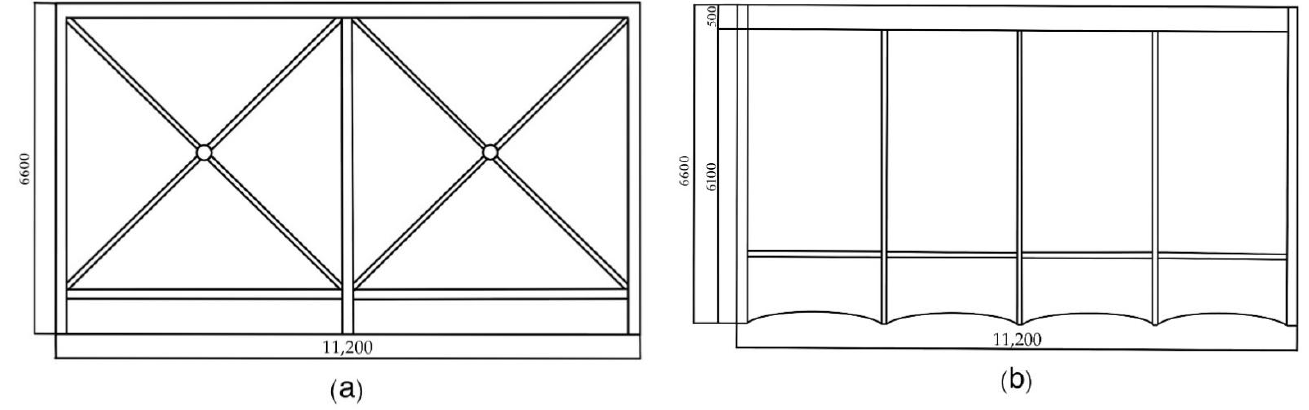
Figure 5. The plan views of the two types of carport structures based on field measurements. ( a ) The plan view of the hat-shaped carport; ( b ) The plan view of the flat-topped carport.